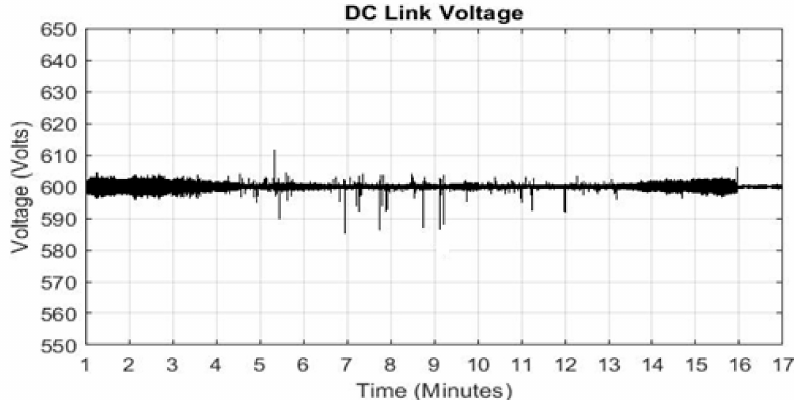
Figure 30. DC link voltage for load profile 3 with flywheel operation.